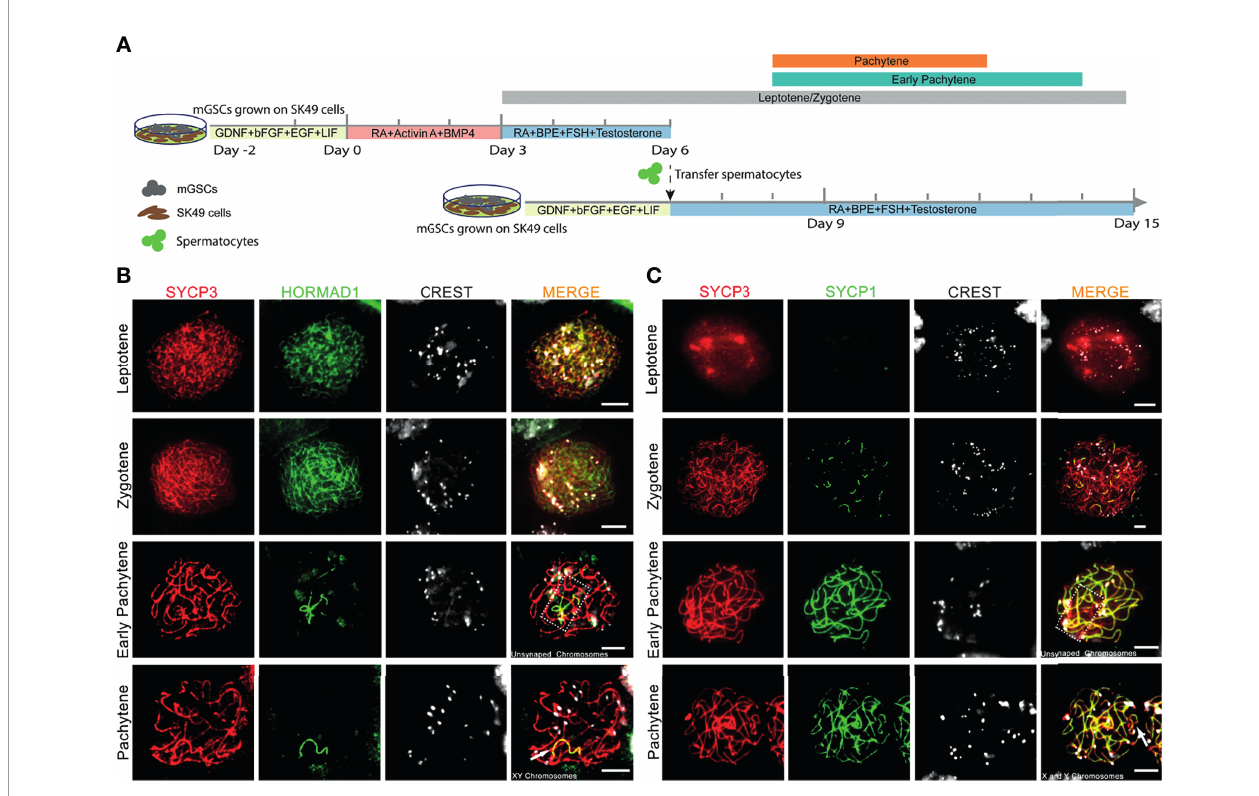
FIGURE 1 | Complete homologous chromosome synapsis during in vitro meiosis. (A) . Schematic overview of the in vitro meiosis culture system. Bars above the timeline represent the period of relatively highly abundant presence of leptotene, zygotene, early pachytene and pachytene spermatocytes. (B, C) Unsynapsed chromosomes marked with HORMAD1 (B) , and synapsed chromosomes marked with SYCP1 (C) in in vitro -generated spermatocytes stained for SYCP3 (red), centromeres (CREST, white), HORMAD1 (green) or SYCP1 (green). Unsynapsed chromosomes and X and Y chromosomes are shown in dashed box or by arrowhead respectively. Scale bars,